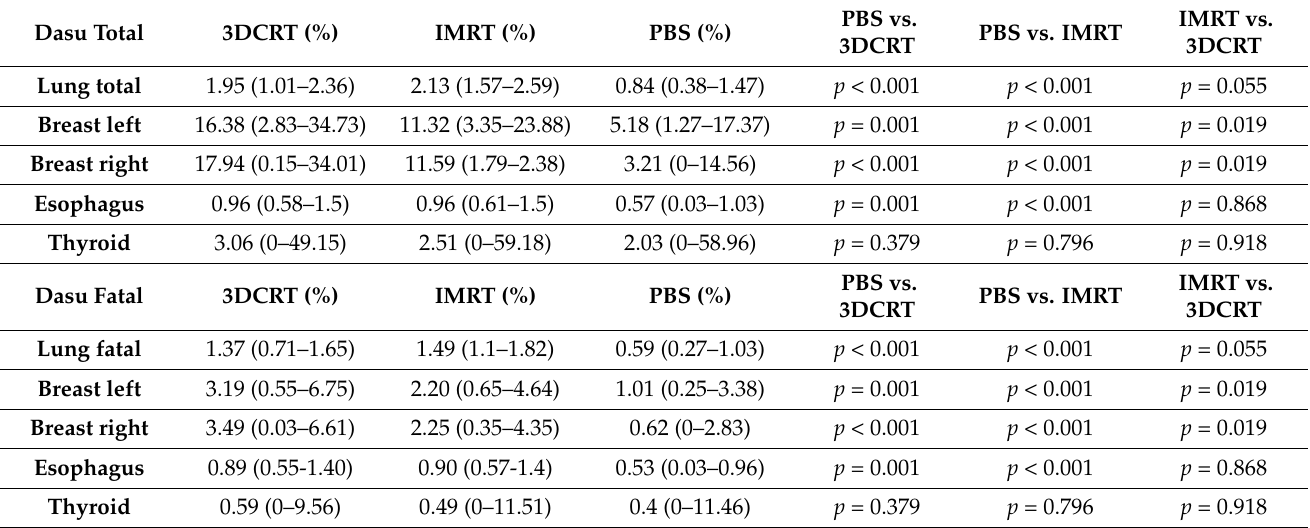
Table 4. Median fatal and total secondary risk values of the Dasu model in percentage for the different techniques.